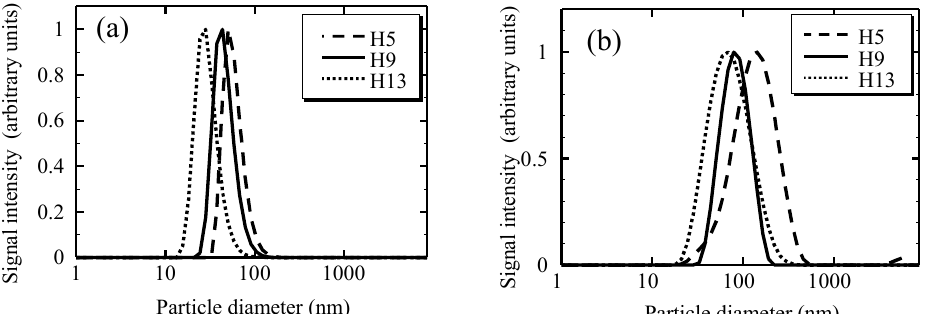
Figure 1. Number-weighted distribution ( a ), and intensity-weighted distribution ( b ) of 0.1 wt.% HGHGH (H5, dashed line), HGGGHGGGH (H9, solid line), and HGGGGGHGGGGGH (H13, dotted line) aqueous solutions at 5 kGy.